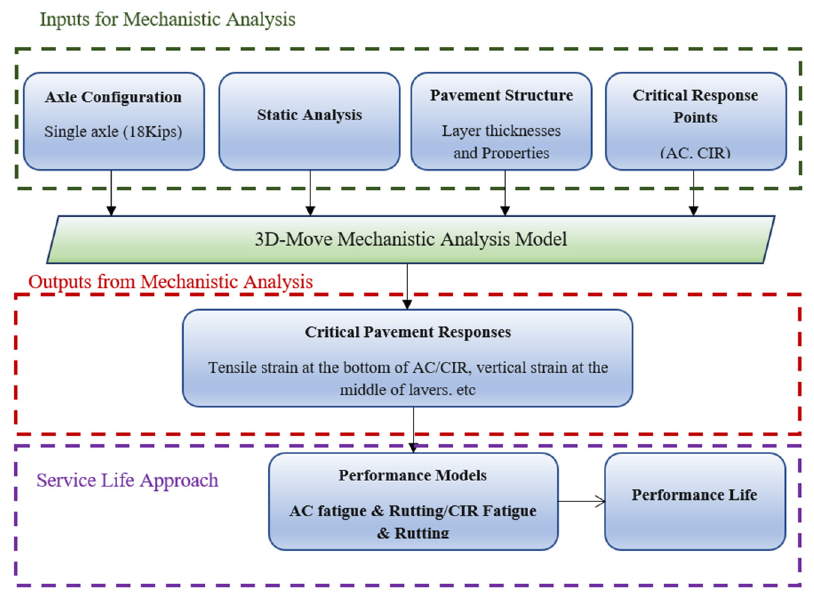
Figure 2. Flow chart of mechanistic analysis approach.